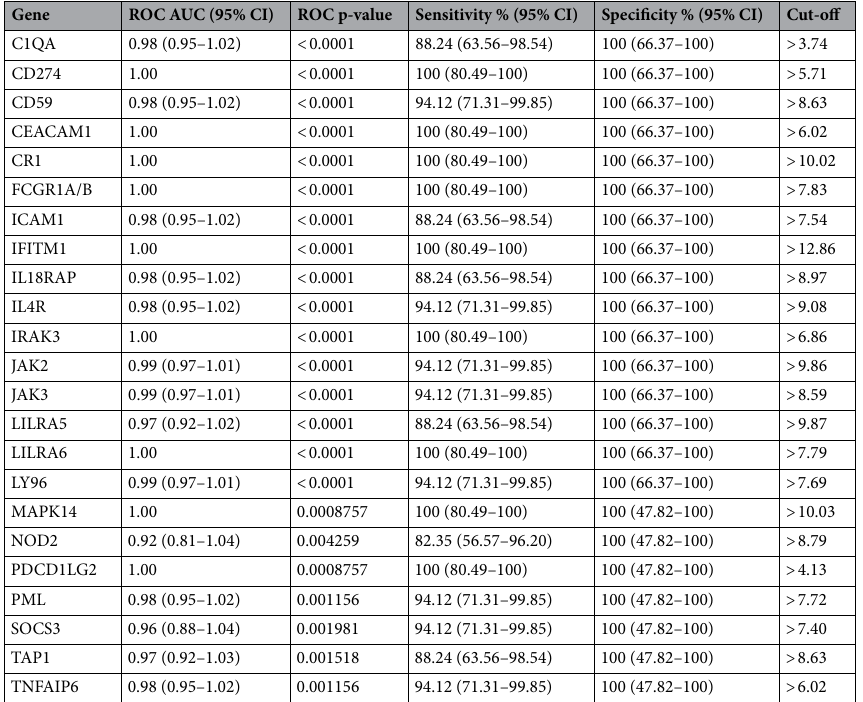
Table 2. ROC analysis, sensibility and specificity of candidate genes to TB diagnosis.